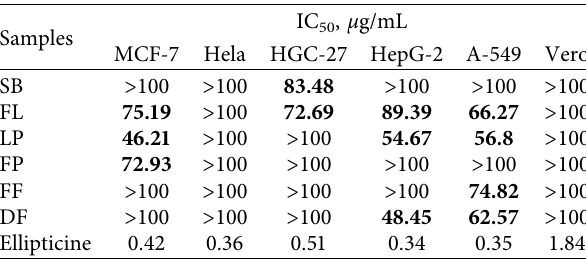
Figure 2: The main constituents in six essential oil samples. Table 2: Cytotoxic activity of essential